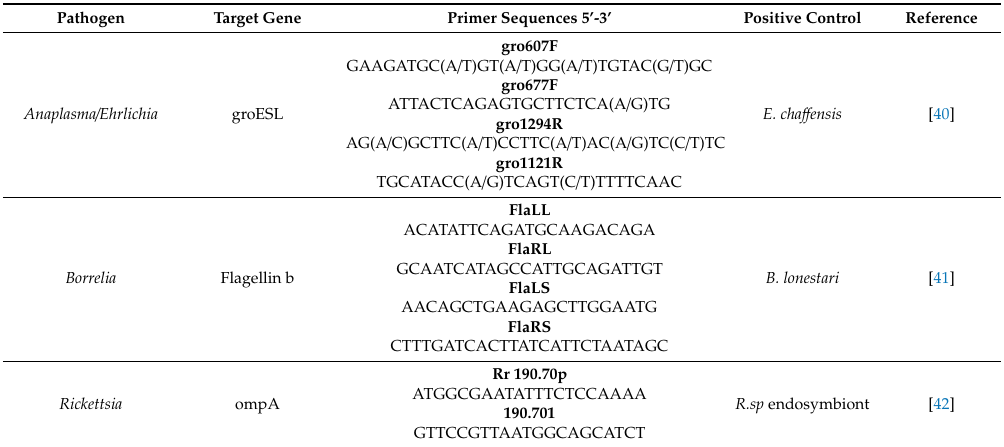
Table 2. Published PCR assays used in this survey. The table includes the targeted gene, primer sequence and positive